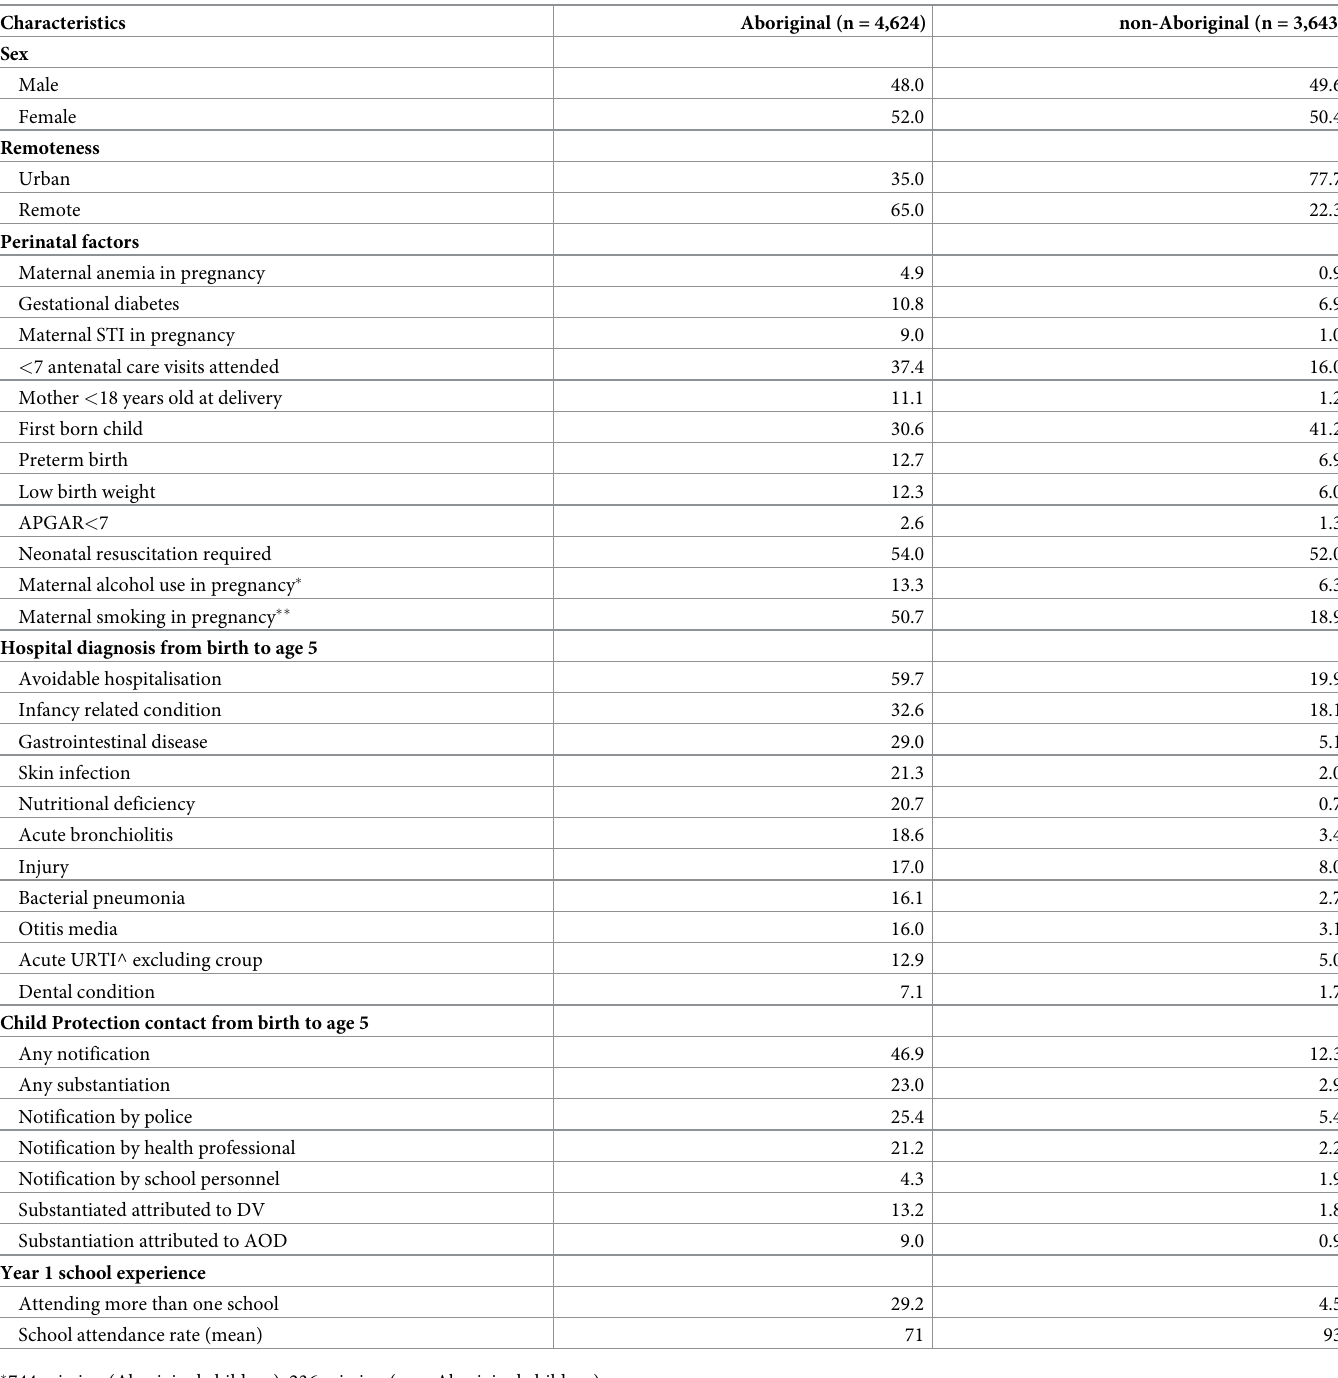
Table 1. Characteristics (%) of our study cohort born in the NT from 2006 to 2009.